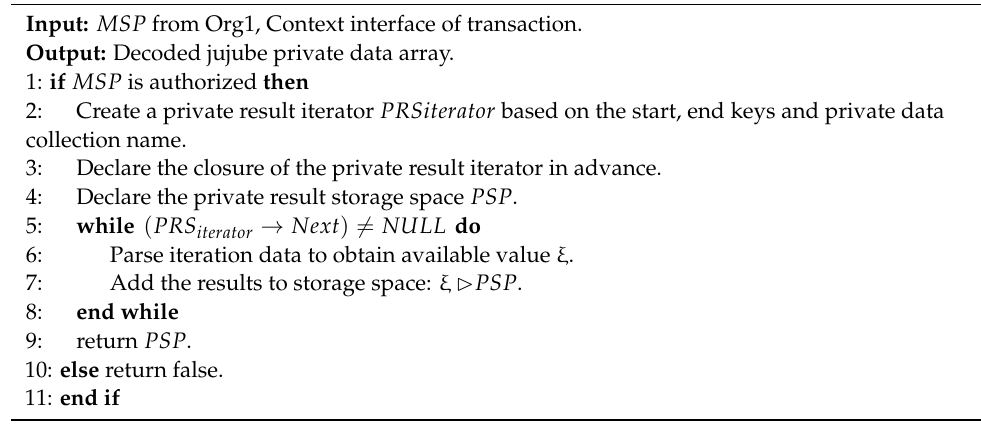
Algorithm 3 Process of Reading Jujube Data in the Private Transaction